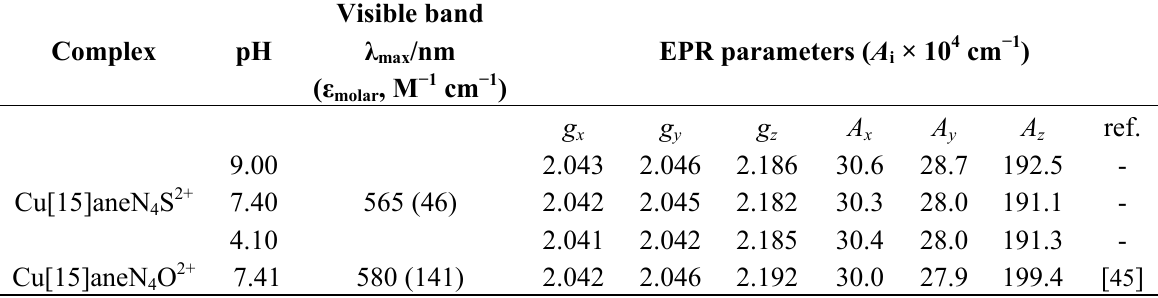
Table 5. Spectroscopic X-band EPR data for the Cu(II) complexes of [15]aneN related ligand [15]aneN 4